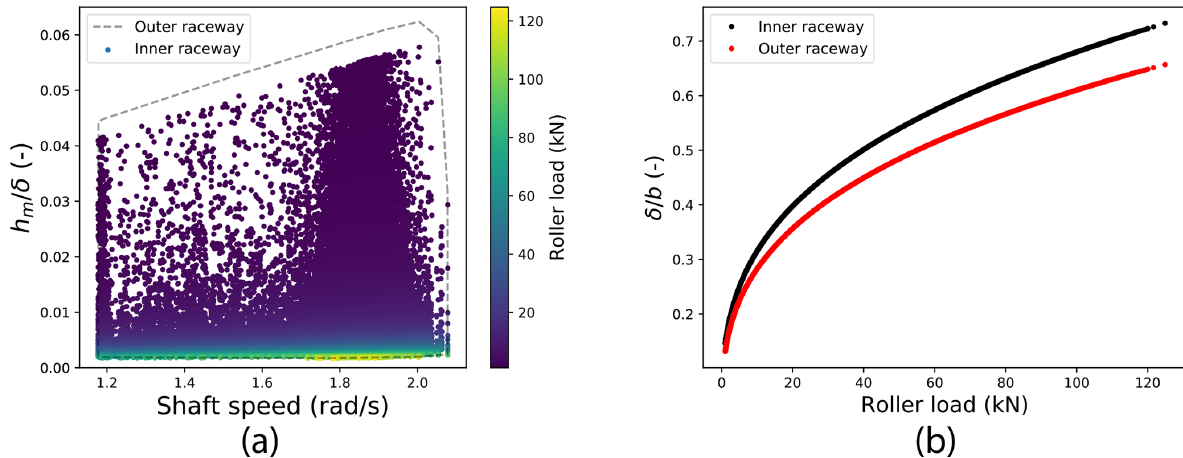
Figure C1. Contact dimension ratios plotted against shaft speed and/or roller load values.